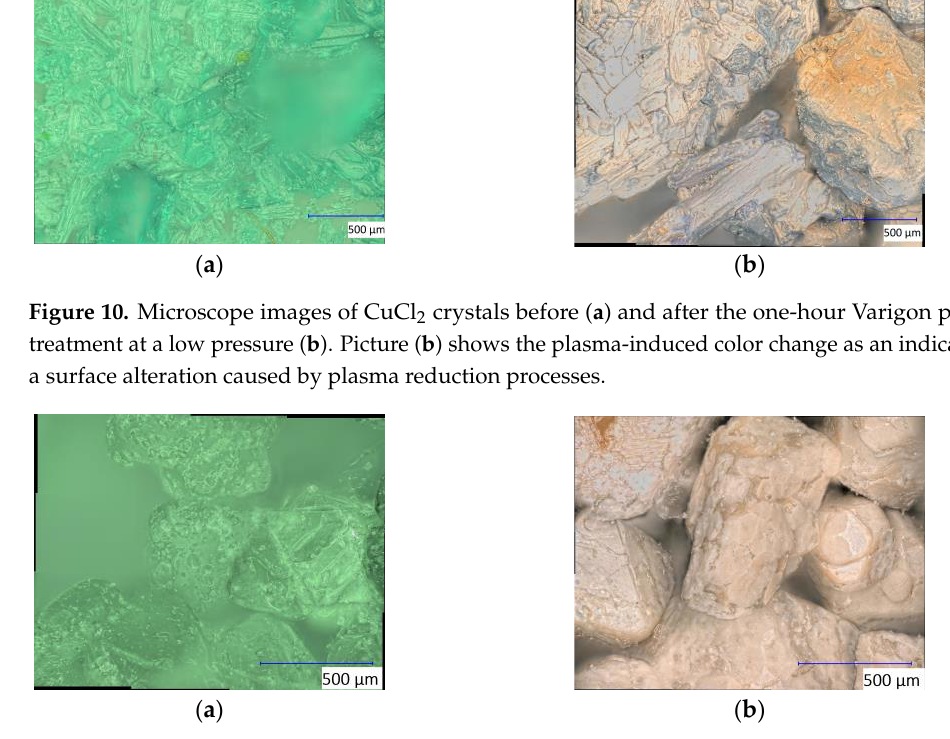
Figure 11. Microscope images of FeSO 4 crystals before ( a ) and after the one-hour Varigon plasma treatment at low pressure ( b ). The comparison of the two pictures shows a clear discoloration, which indicates a Varigon plasma-induced change in the chemical composition of the surface. These discolorations are indicative of the formation of different copper oxide